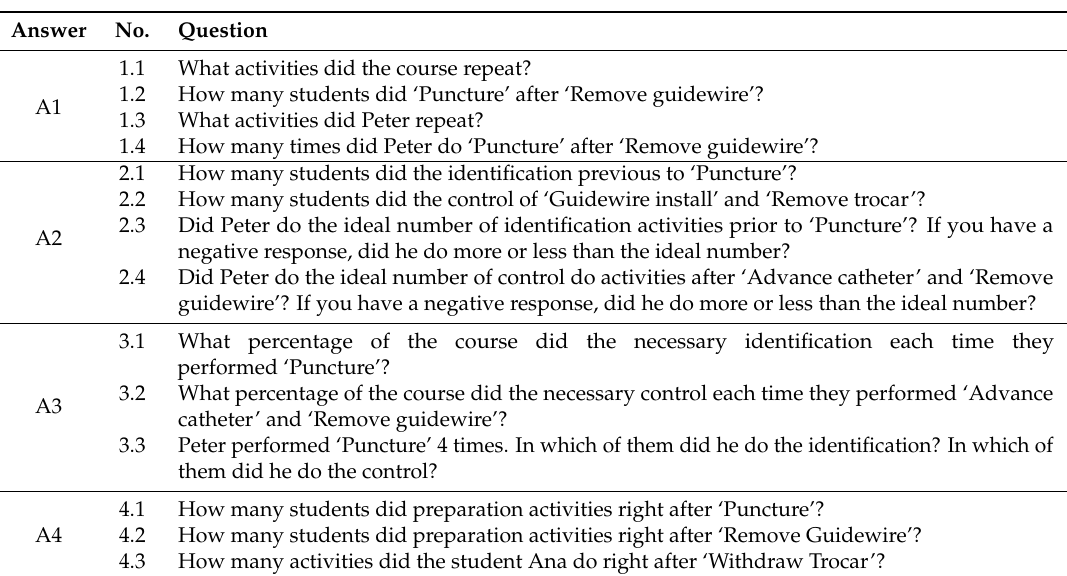
Table 4. Interpretability test